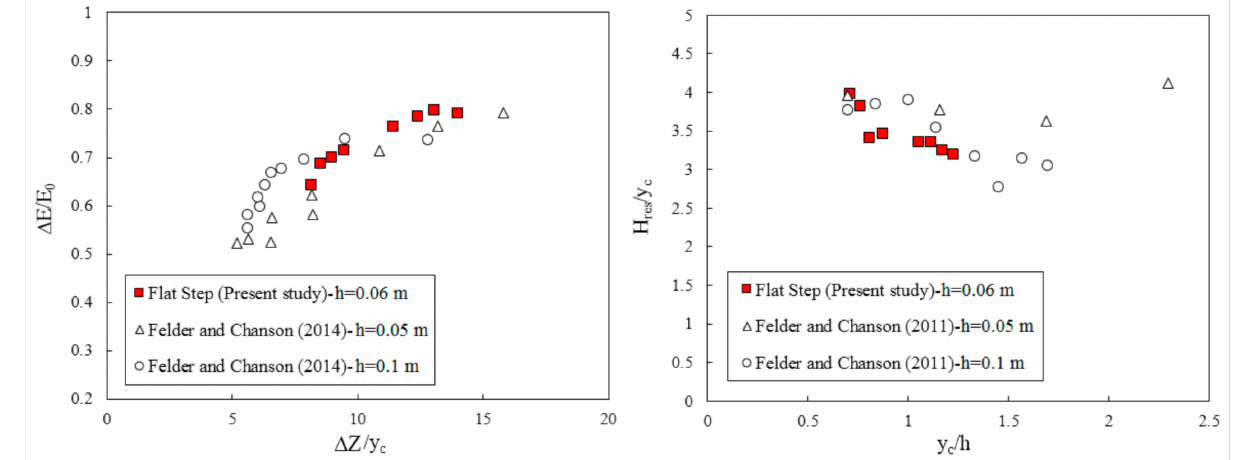
Figure 12. The rate of energy dissipation and residual head for flat steps.